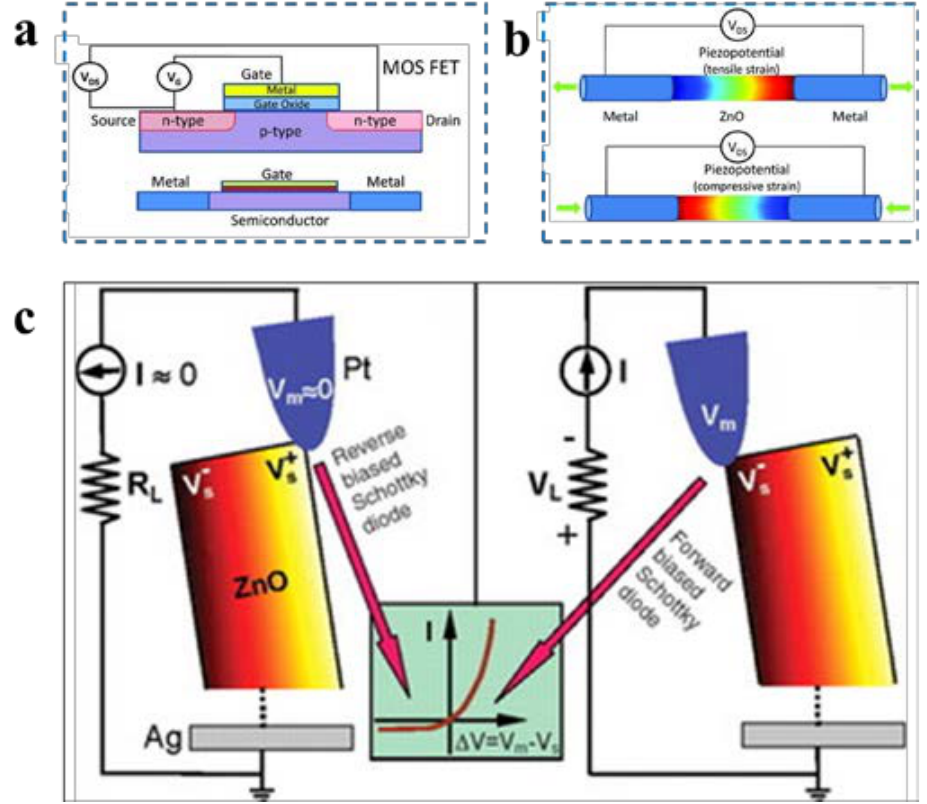
Figure 4. ( a ) Schematic diagram of a semiconductor nanowire field-effect tube. ( b ) Schematic diagram of a piezoelectric transistor [50]. ( c ) Working principle of a ZnO nanogenerator [65]. Unlike conventional field-effect transistors, piezoelectric transistors use the piezoe- lectric potential generated by piezoelectrically polarized bound charges as the gate volt- age signal to regulate the carrier transport characteristics of the transistor instead of the gate voltage (Figure 4b) [50]. A typical representative is the piezoelectronic nanogenera- tor. In 2006, piezoelectric nanogenerators were first proposed [65], using the tip of an atomic force microscope to poke a ZnO nanowire and measuring a nanowire piezoelectric output signal of 8 mV. The output power of a single ZnO nanowire is very small. To in- crease the output power of the piezoelectric nanogenerator, as well as to move away from the dependence on AFM and transform the piezoelectric nanogenerator from a concept to a practical technology, an innovative design of the structure of the piezoelectric nanogen- erator is required. Based on the existing piezoelectric nanogenerator designs, piezoelectric nanogenerators can be broadly classified into two categories: Schottky-contact-structure- based piezoelectric nanogenerators, and sandwich-structure-based piezoelectric nano- generators. Taking ZnO as an example, the operating principle of ZnO nanogenerators exploits the coupling of the semiconductor properties of ZnO material with piezoelectric properties. The initial study of the piezoelectric properties of ZnO utilized ZnO nanorods (Figure 4c) that were allowed to bend under the action of an AFM probe. This deformation causes a certain deviation of Zn 2+ and O 2- , whose original centers of symmetry coincide within ZnO, to generate a piezoelectric potential, with the stretched side of the nanorod gathering a positive charge, and thus a positive potential, and the compressed side gath- ering a negative charge, i.e., a negative potential [65]. 3. Bone Regeneration Based on Piezoelectric Material and Devices 3.1. Piezoelectric Materials and Devices Applied in Cells Bone healing is the process of repairing a fracture or bone defect, which is essentially a regenerative process after a bone injury. Ideally, after the repair process, only the bone tissue is rebuilt without scar formation. However, studies have found that 5% to 10% of patients still suffer damage during the bone healing process, resulting in delayed bone healing or the non-healing of bone. Cell proliferation and differentiation are essential bi- ological processes in the bone healing process. The cells of bone tissue mainly include bone marrow mesenchymal stem cells (BMSCs), osteoblasts, osteocytes, and osteoclasts. Only osteocytes are present within the bone tissue, while the other three types of cells are located at the edges of the bone tissue. Currently available studies on the piezoelectric